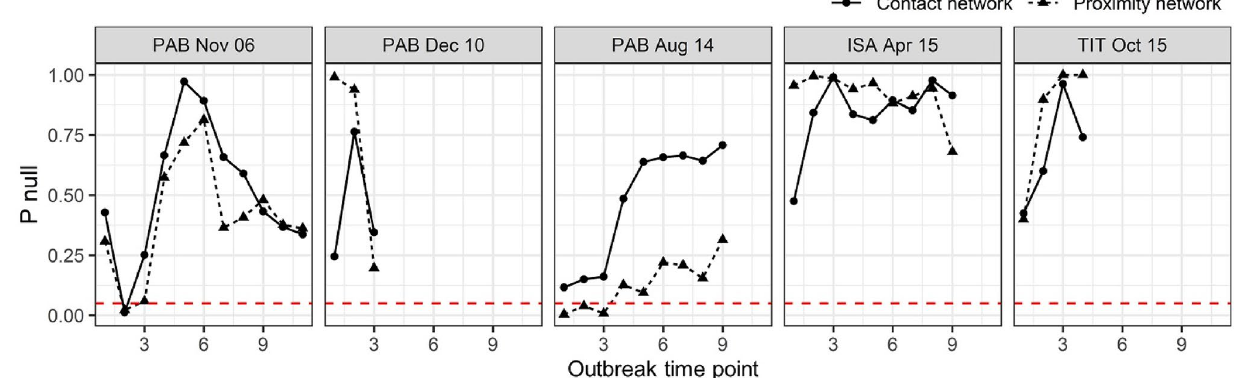
Figure 3. The proportion of null models (P null) for which the mean weighted path length between individuals showing signs of infection was shorter than that observed in the real outbreak, at each outbreak time point (each day of the outbreak on which at least one group member showed signs for the first time) for each outbreak. Outbreaks with fewer than 2 time points were not plotted. Dashed red line indicates a P null of 0.05, i.e. that path lengths between individuals showing signs of infection in the real outbreak were shorter than expected by chance, supportive of transmission through the social network. For visualisations of the spread of signs across each network see the supplementary